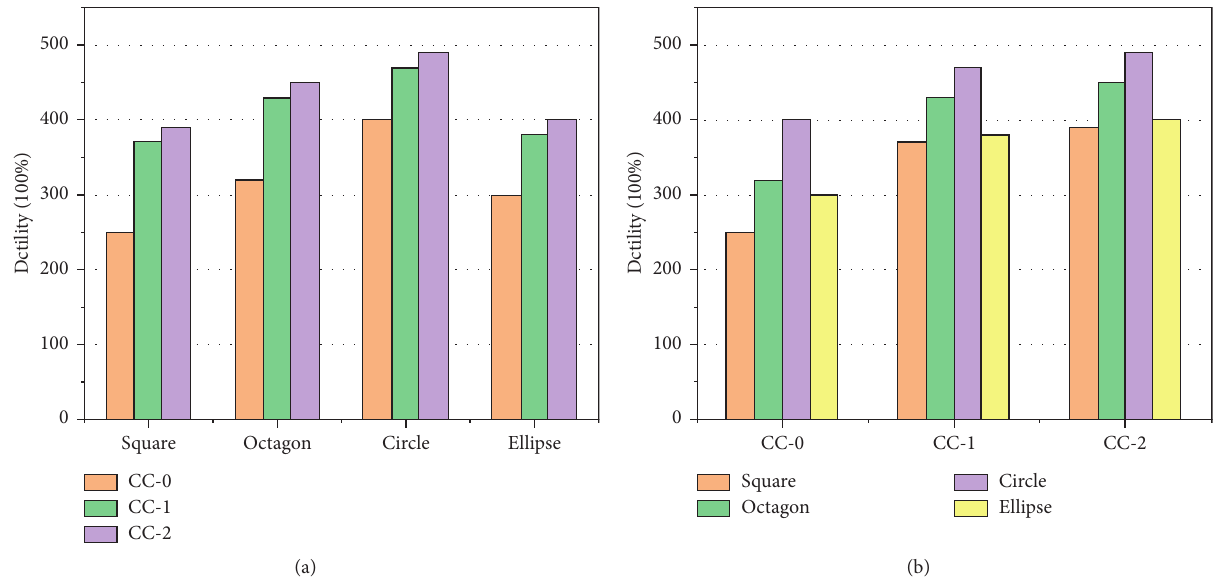
Figure 8: The ductility of the columns with different cross-sectional shapes and CC layers. (a) Cross-sectional shape. (b) CC layers.